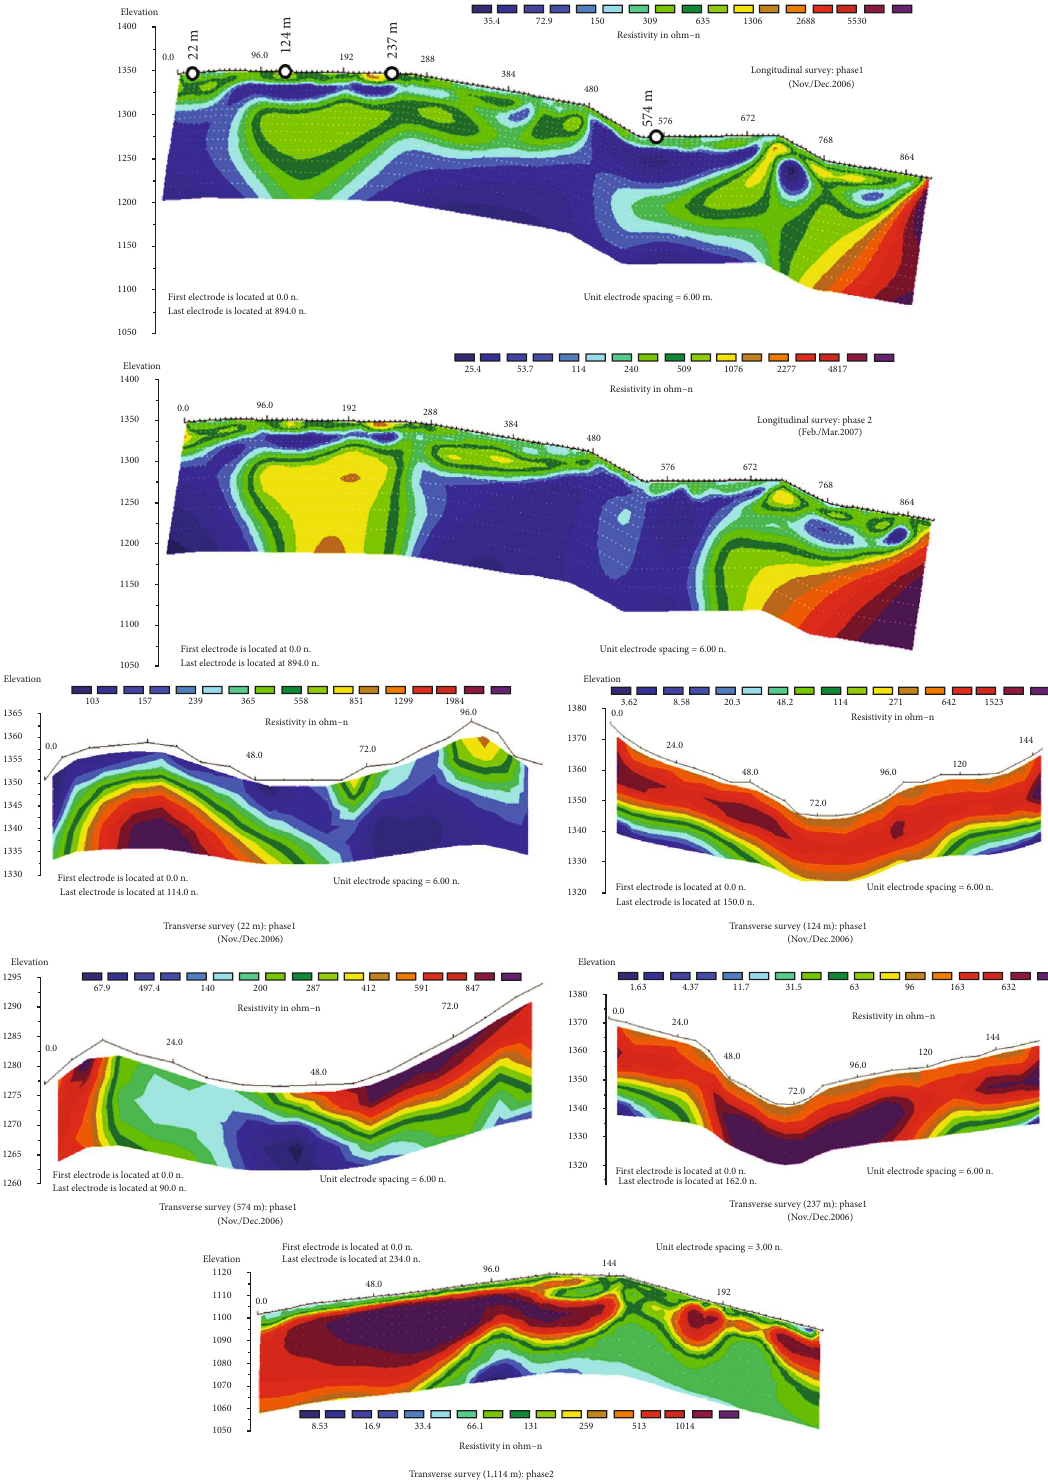
Figure 21: Longitudinal and transverse resistivity pro fi les of Karli spillway from RES2DINV modelling integrating data from two phases on fi eld